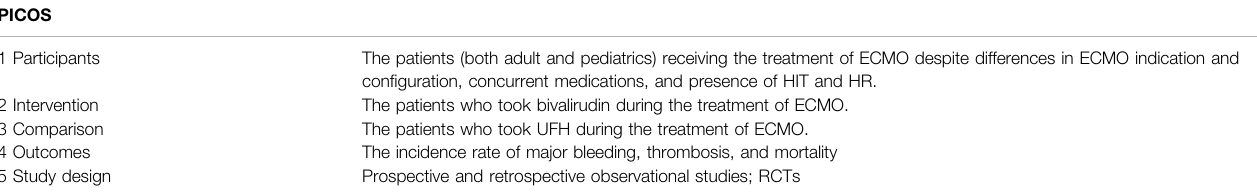
TABLE 1 | ‘‘ PICOS ’’ approach for selecting clinical studies in the systematic search.